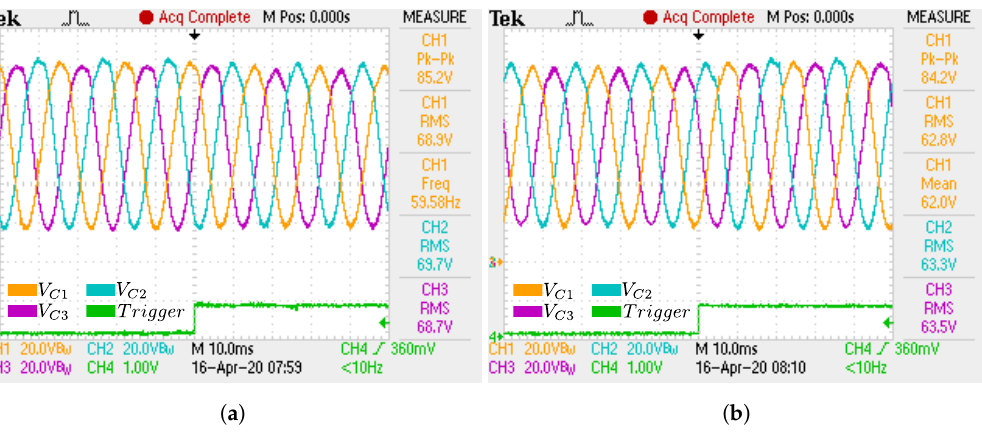
Figure 34. Experimental capacitor voltages for RL transition load: ( a ) First transition; ( b ) Second transition.